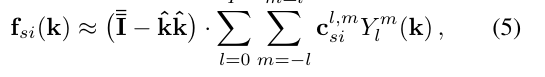
Figure 1: Singular values of the coefficient matrices C x C y and C z for an example structure inside a group with 1 1 edge length of 0.5 λ . The box includes a flat plate as an example for the content of boxes in the entire